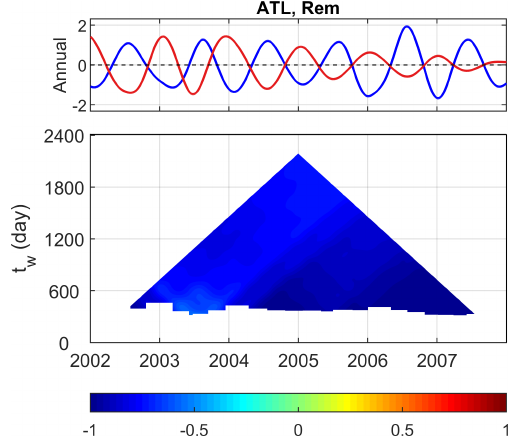
Figure 10. Decomposed annual cycles in Atlanta, GA, for the re- maining components presented in total PM 2 . 5 other than the five species in Fig. 9.